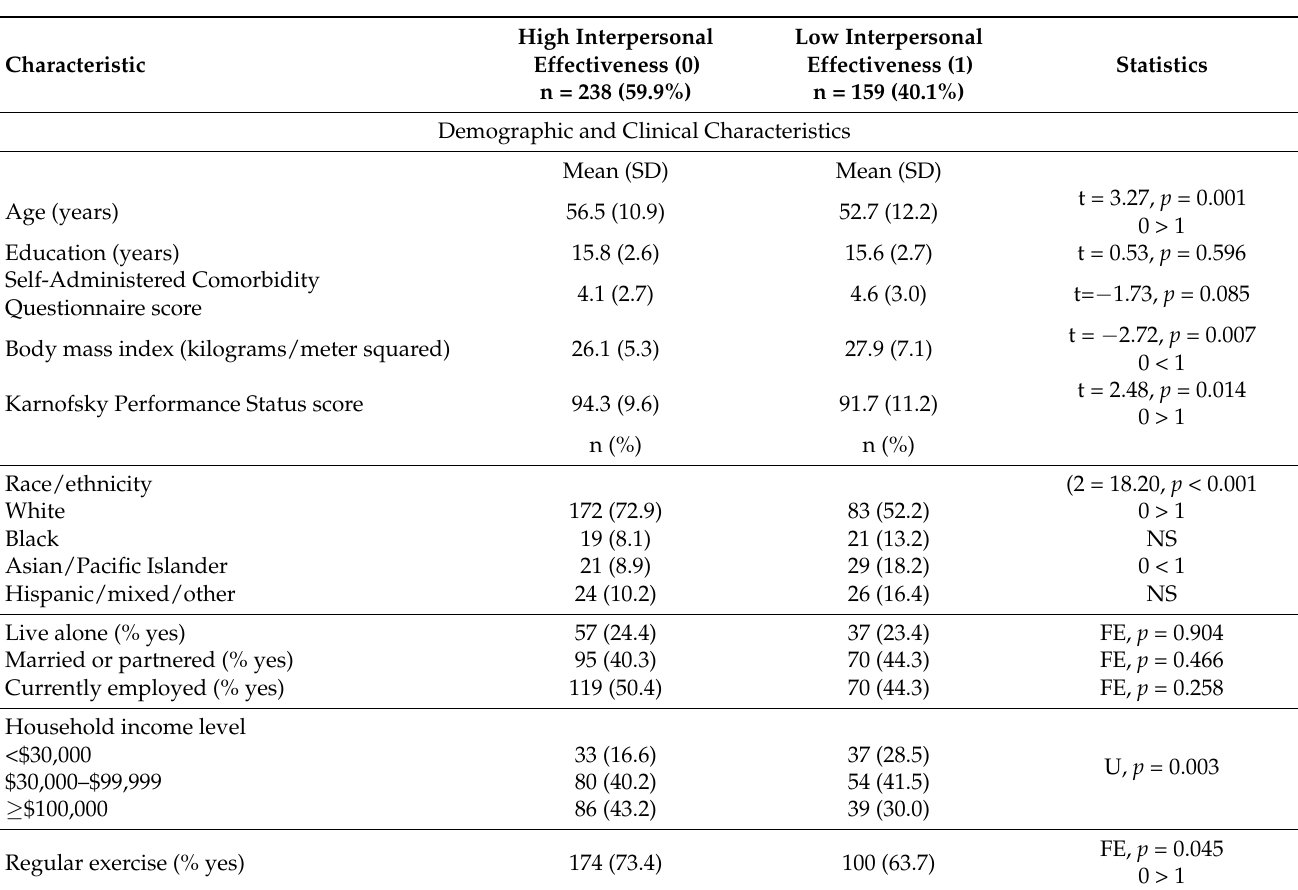
Table 6. Differences in Demographic, Clinical, and Symptom Characteristics Among the Interpersonal Effectiveness